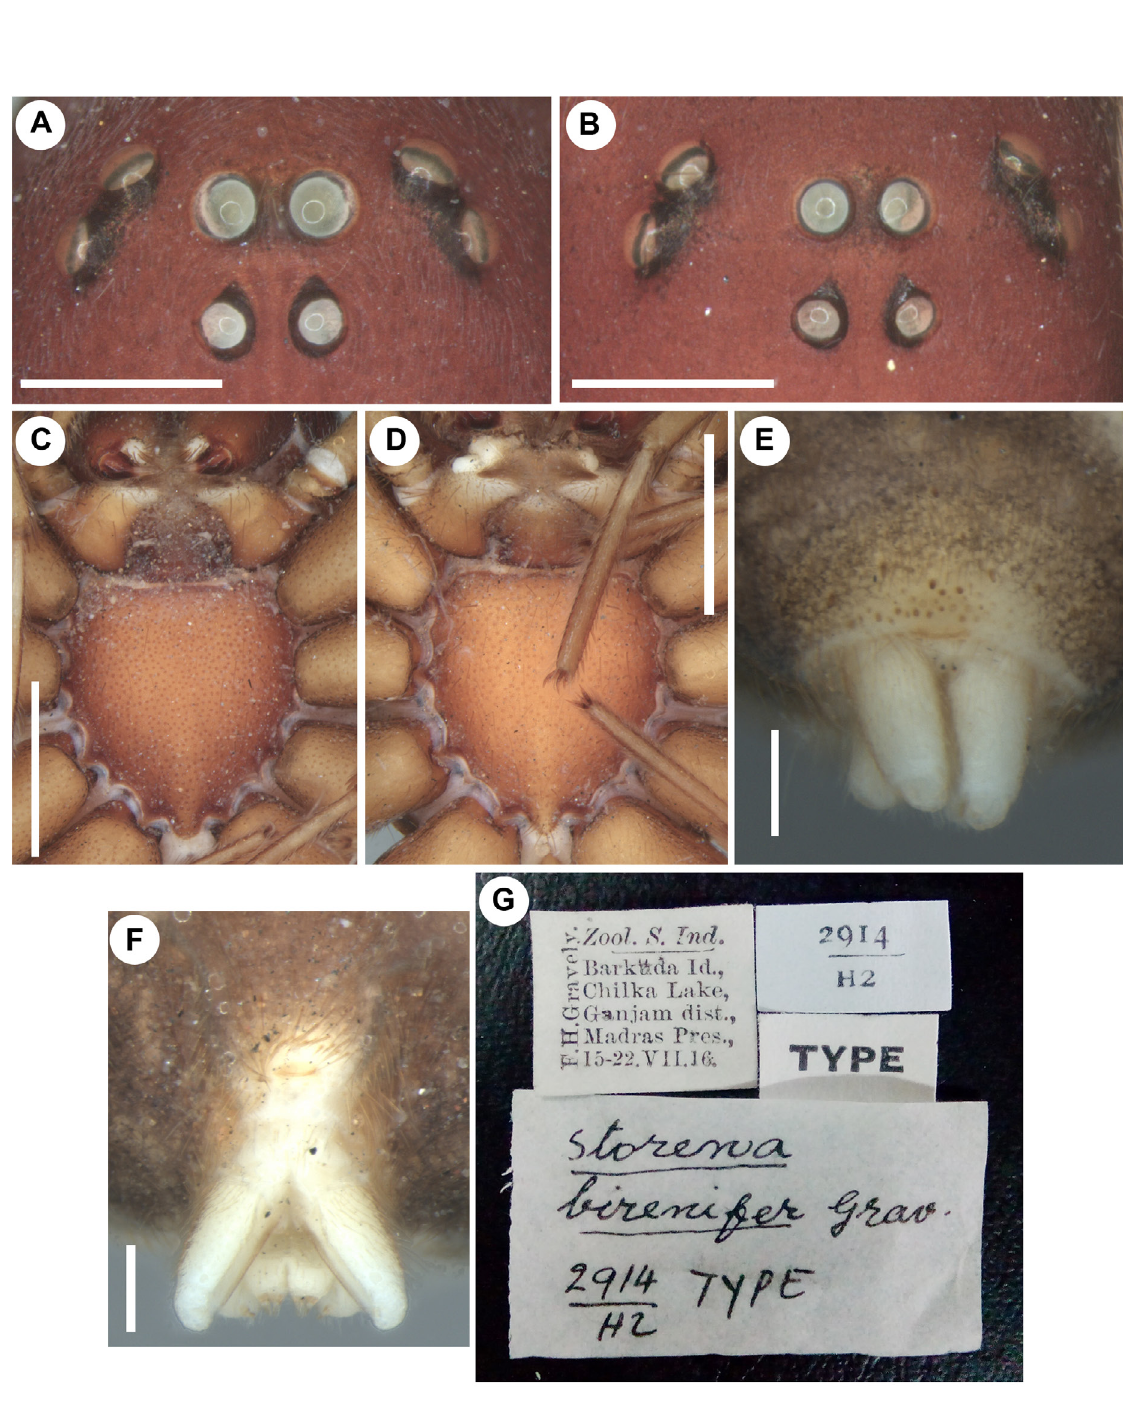
Fig. 2. Laminion birenifer (Gravely, 1921) gen. et comb. nov., ♂♀, syntypes of Storena birenifer Gravely, 1921. A , C , E . ♂ (NZC-ZSI-2914/H2). A . Eye group, fronto-dorsal view. C . Endites, labium and sternum, ventral view. E . Spinnerets, ventral view. B , D , F . ♀ (NZC-ZSI-2914/H2). B . Eye group, fronto-dorsal view. D . Endites, labium and sternum, ventral view. F . Spinnerets, ventral view. G . Type label. Scale bars: A–B = 0.5 mm; C–D = 1 mm; E–F = 0.2